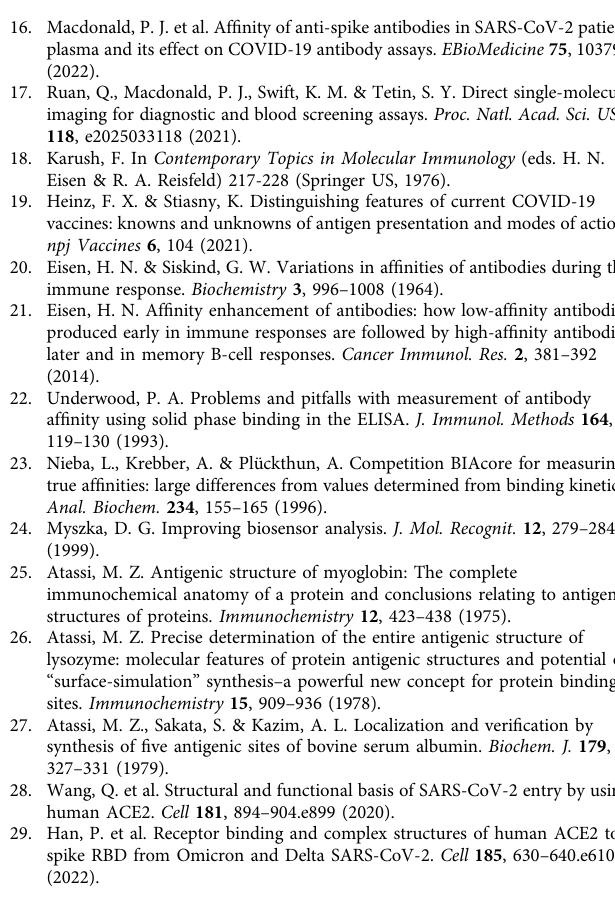
Fig. 4 Sequence alignment and structures of SARS-CoV-2 RBD variants. a The sequence alignment chart of the RBD constructs used in this study, showing mutations noted in blue (Delta) and green (Omicron). b Structural surface and cartoon representation of WT SARS-CoV-2 RBD (grey, PDB: 6LZG), with color-coded surface mutations for Delta- (blue, PDB: 7WBQ) and Omicron-RBD (green, PDB: 7WBP) 28,29 . Note that most mutations cluster on the ACE2 binding